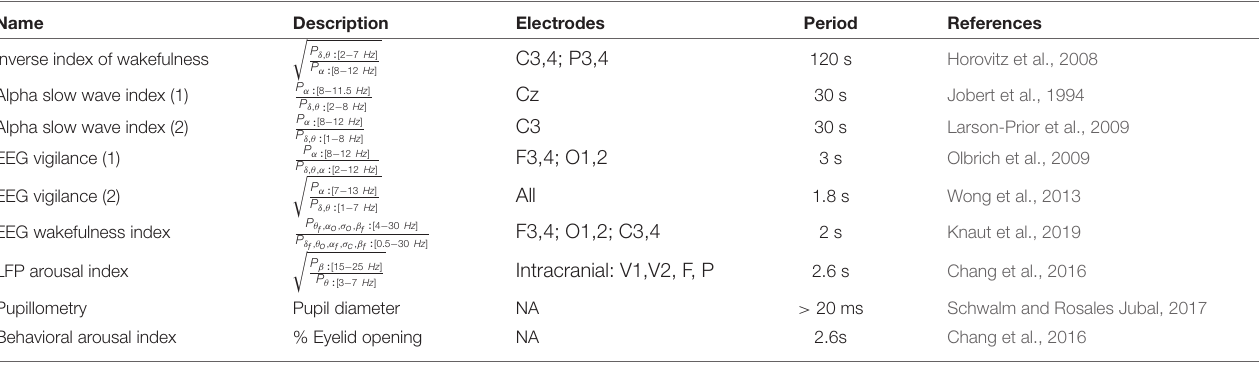
TABLE 1 | Vigilance